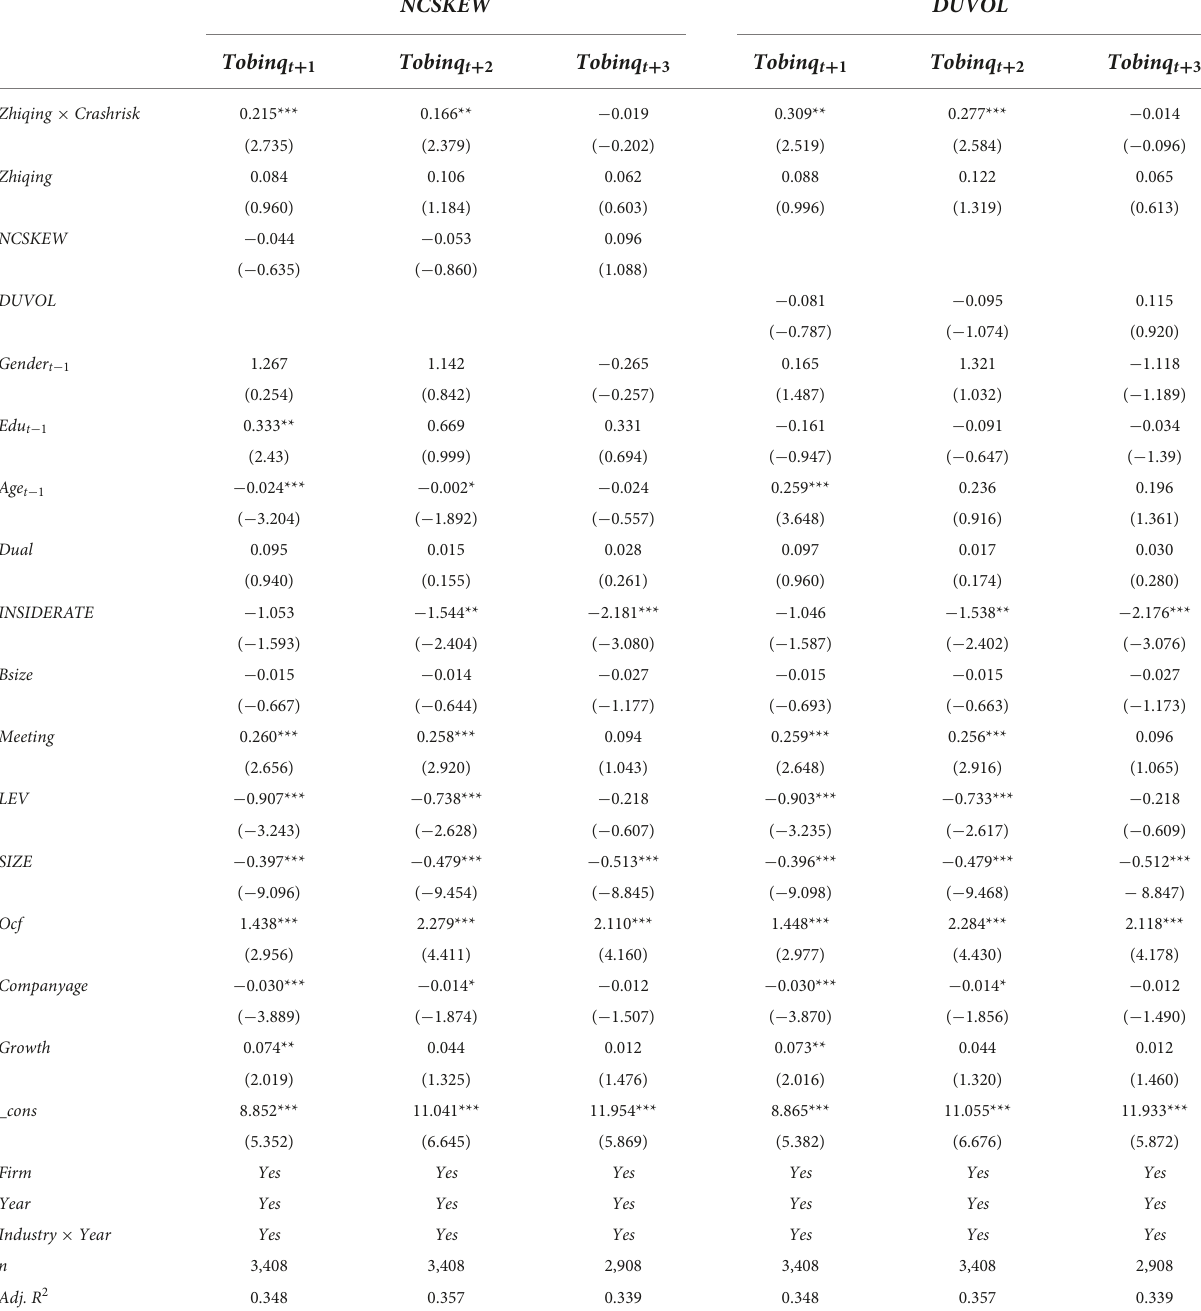
TABLE 12 Influence of Down to the Countryside experiences on firm